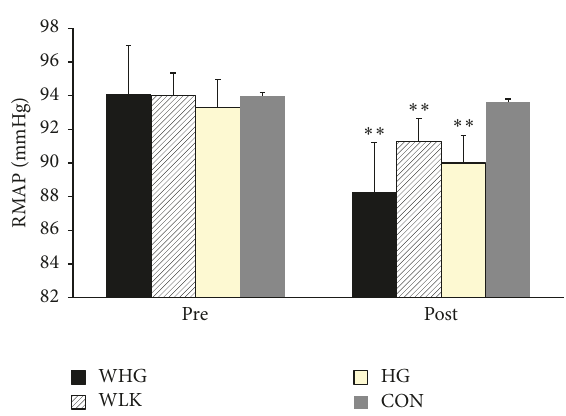
Figure 2: Resting mean arterial pressure (RMAP) for the simultane- ous walking and handgrip (WHG), walking (WLK), handgrip (HG), and control (CON) groups before and after training. ∗∗ 𝑃 value <